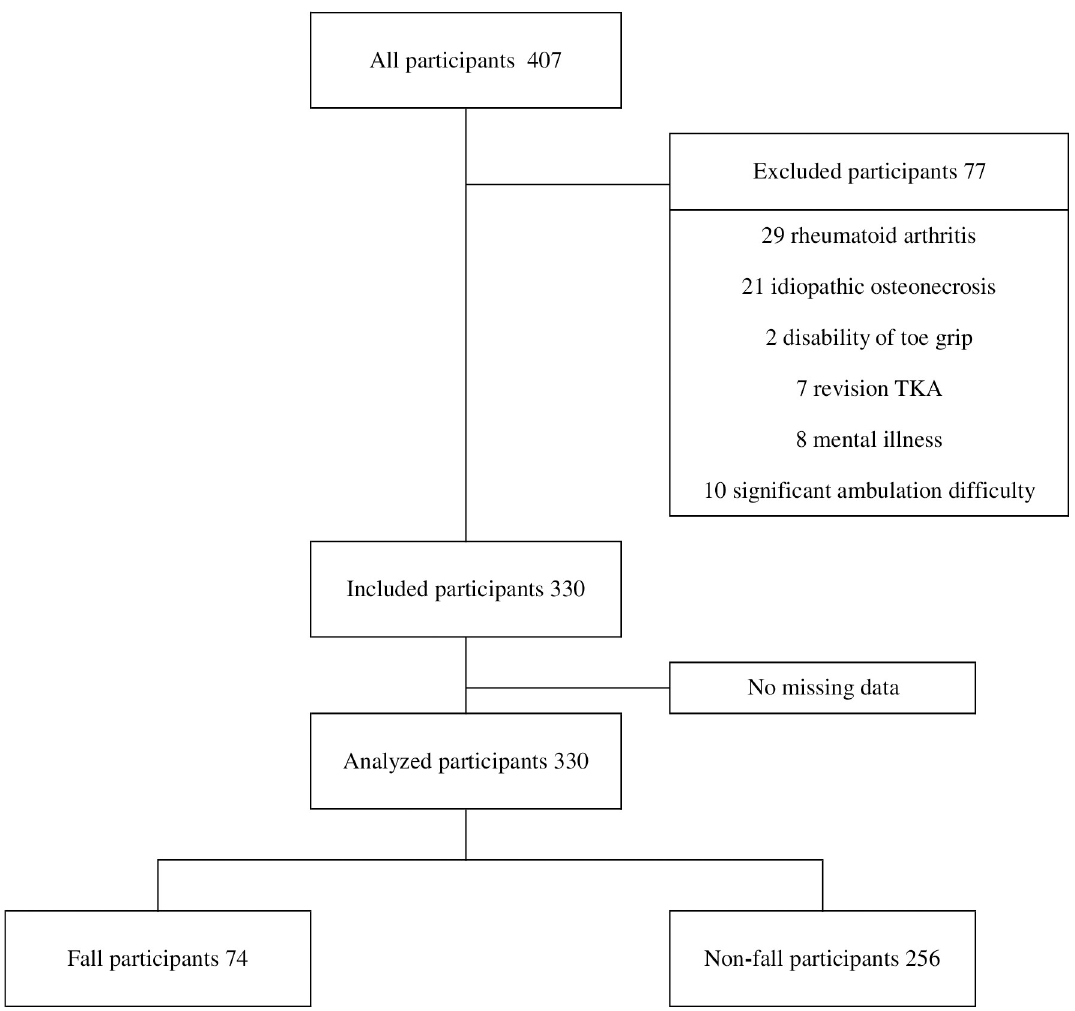
Fig 2. Flow diagram of the study participants’ inclusion